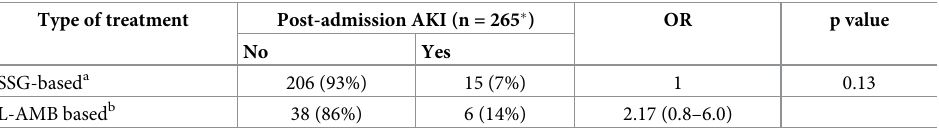
Table 4. Rate of post-admission AKI per initial treatment allocation among patients with VL with baseline nor- mal kidney function at LRTC between January 2019 –December 2019, Gondar, Ethiopia, N = 268. Type of treatment Post-admission AKI (n = 265 �